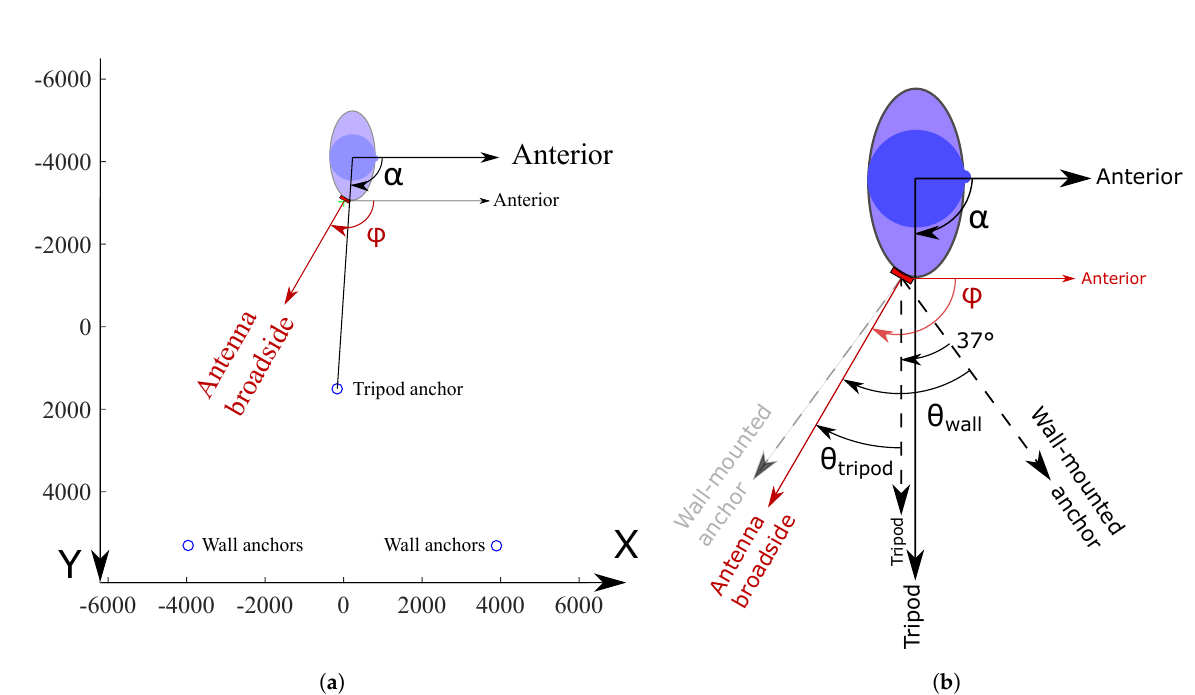
Figure 9. Body-worn positioning experiment. α is the angle between the user’s anterior direction and the direction of the tripod. φ is the angle between the user’s anterior direction and the textile antenna’s broadside orientation. ( a ) Anchor and test subject (not to scale) positions in mm with the anchor positions displayed as blue circles. Both anchors at the highest Y coordinate consists of two anchor nodes stacked on top of each other. For exact coordinates, please refer to Table 2. ( b ) Investigation of connectivity between the tripod mounted anchor and the sensor module. The sensor module was deployed at the body position characterized by φ = 120 ◦ . The tripod mounted anchor is located in the azimuthal direction for which α = 90 ◦ . The antenna’s broadside deflection with respect to the tripod mounted anchor is therefore θ tripod = + 30 ◦ . The precise locations of the anchors are given in Table 2.